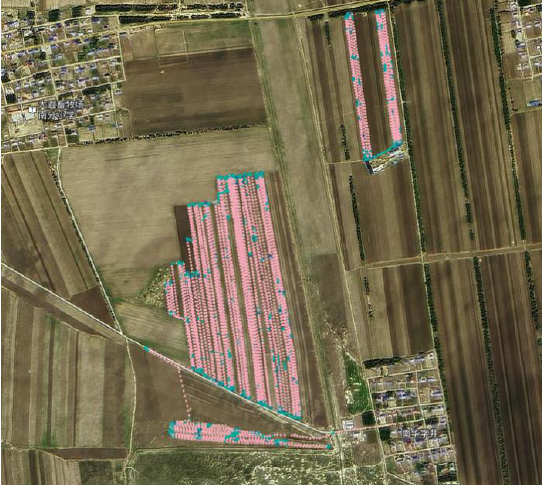
Figure 2. Track point diagram of agricultural machinery deep loosening operation.